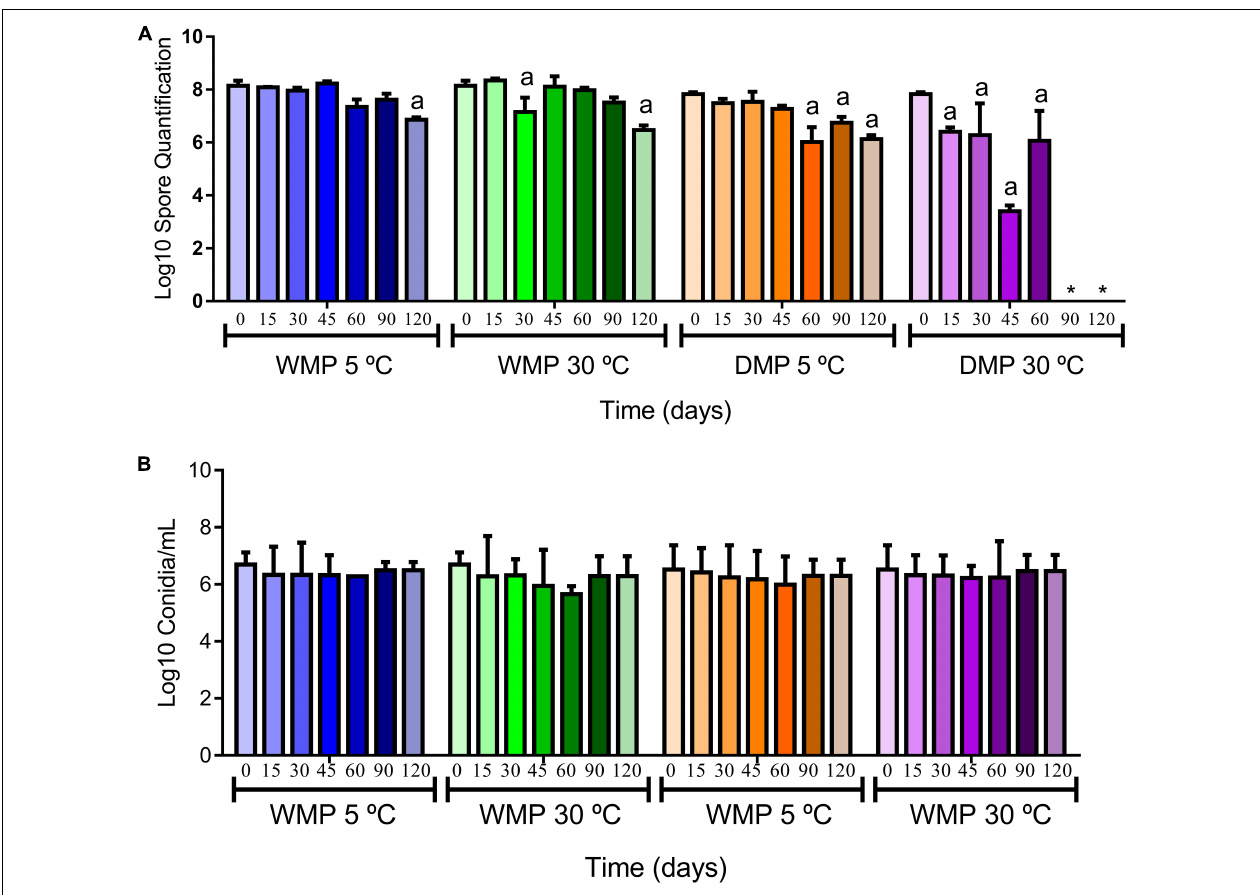
FIGURE 3 | Quantification of the spores of T. harzianum encapsulated in the wet (WMP) and dry (DMP) calcium alginate microparticles, during storage for 90 days at 5 and 30 ◦ C, using the CFU g − 1 and Neubauer chamber techniques. (A) Log10 spore quantification using the CFU g − 1 method applied to the wet and dry microparticles; (B) Log10 quantification of spores (conidia/mL) using the Neubauer chamber method applied to the wet and dry microparticles. The encapsulated fungus presented higher spore viability during the period evaluated. * No conidia growth at this time. a refers to the significant difference in the quantification of spores on the evaluated days when compared to day